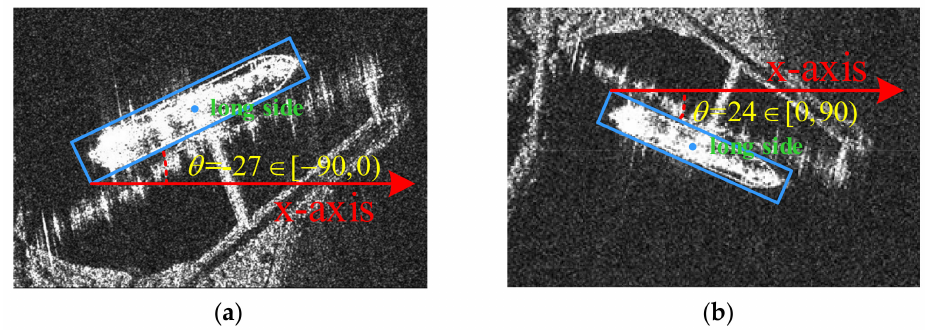
Figure 5. The oriented bounding box (OBB) of ships in SAR images, where θ is determined by the long side of the rectangle and x-axis. ( a ) θ belongs to [ − 90, 0). ( b ) θ belongs to [0,